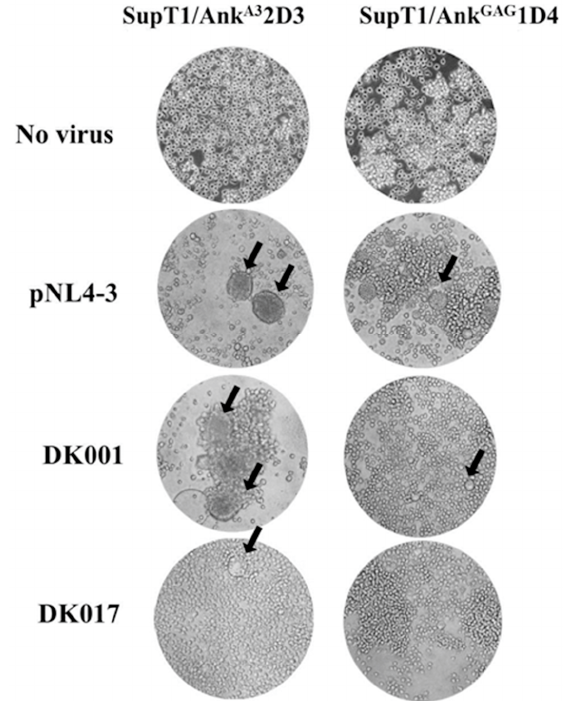
Figure 4. Ank GAG 1D4 inhibits syncytium formation of SupT1 cells after being infected by Gag/PR chimeric viruses induction. SupT1/Ank GAG 1D4 and SupT1/AnkG A3 2D3 were infected with chimeric viruses. The cells were observed at 400 × magnification using an inverted microscope. The black arrows point to syncytia. DK001 and DK007 are two representative samples of the Gag/PR chimeric viruses in cluster 1.